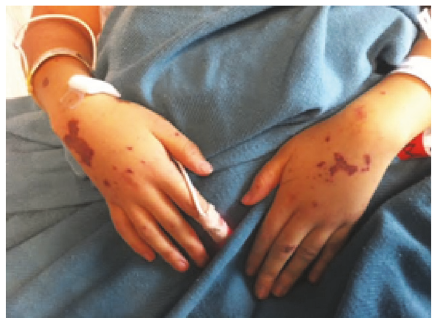
Figure 2: Bilateral upper extremities with purpura, photo cred M. Hoffman